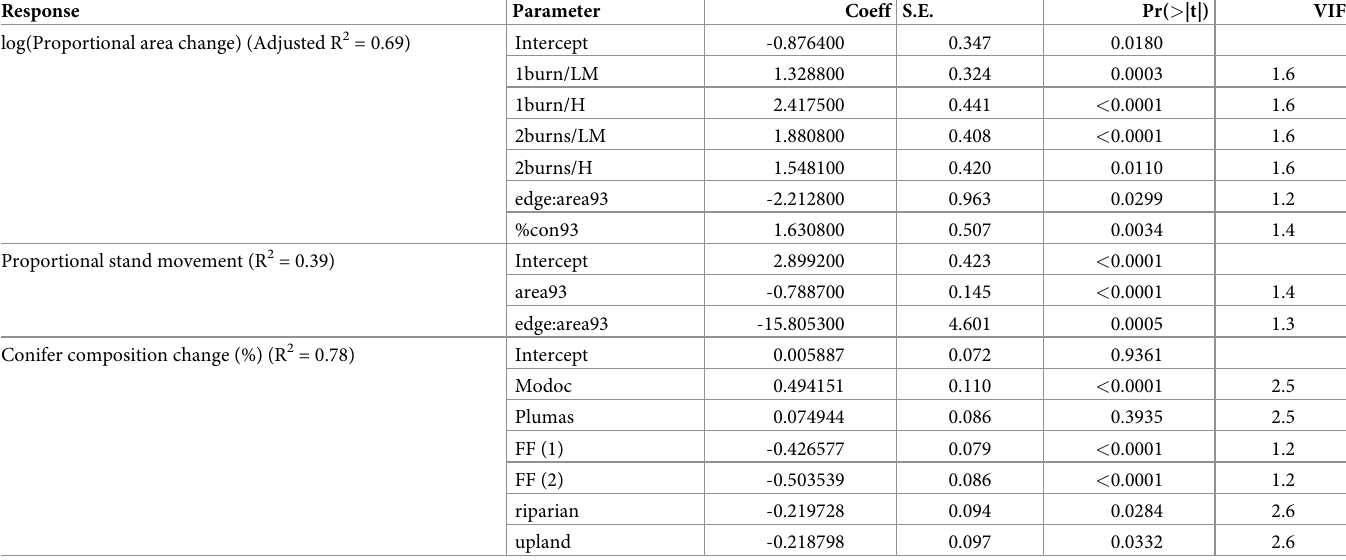
Response Parameter Coeff S.E. Pr( > |t|) VIF log(Proportional area change) (Adjusted R 2 =